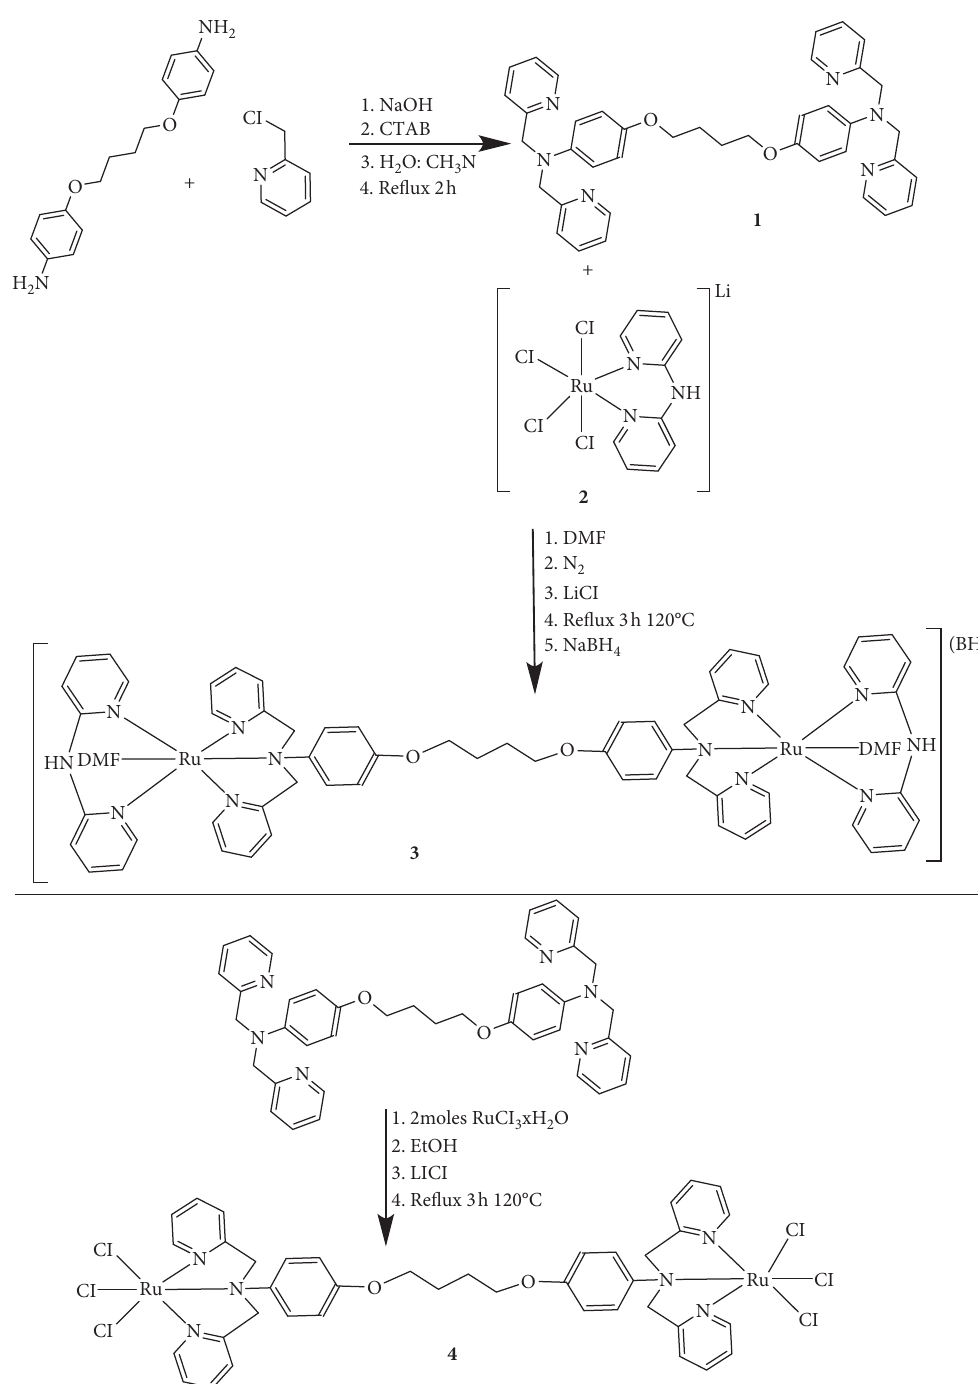
Figure 1: Synthetic routes for the ligand 2BUT (1) and ruthenium complexes: [Ru (4)